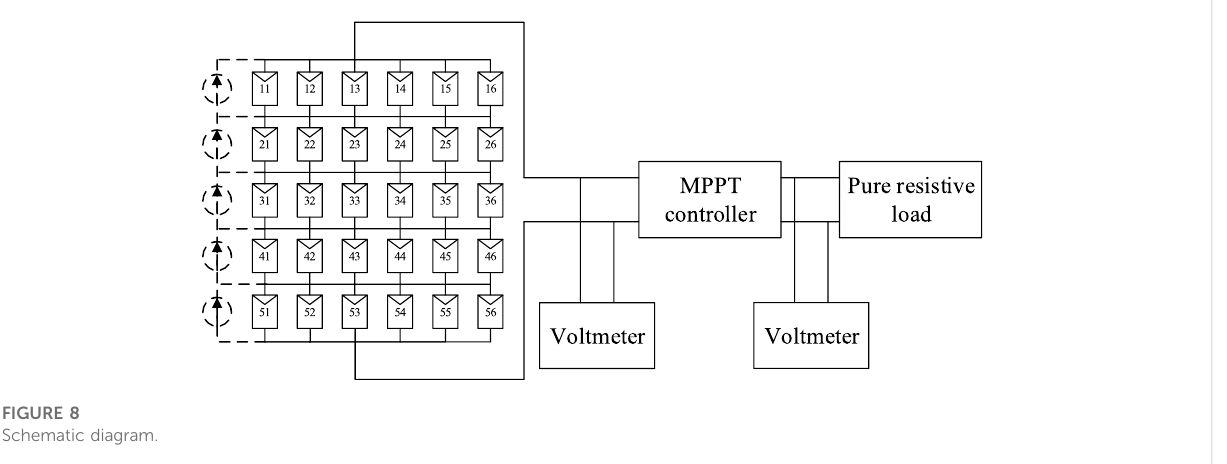
FIGURE 8 Schematic diagram.